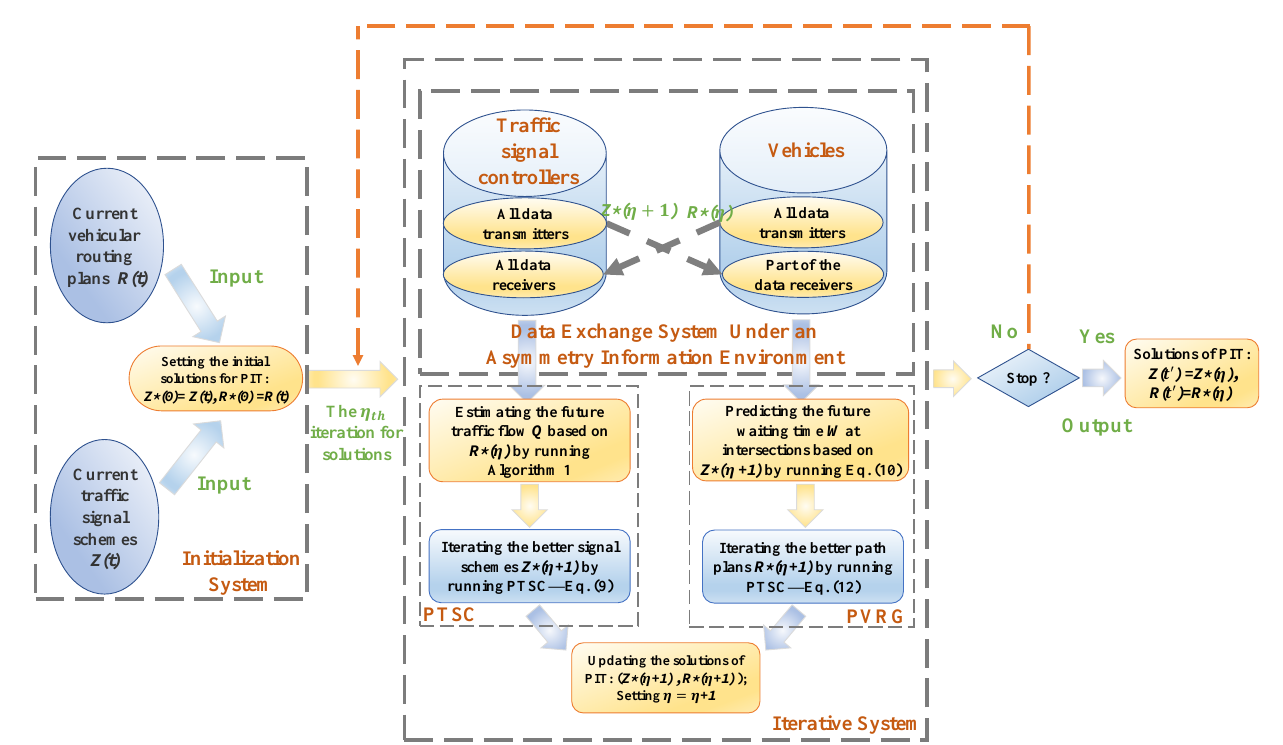
Figure 5. Dynamic game processes and rules in the updating distributed